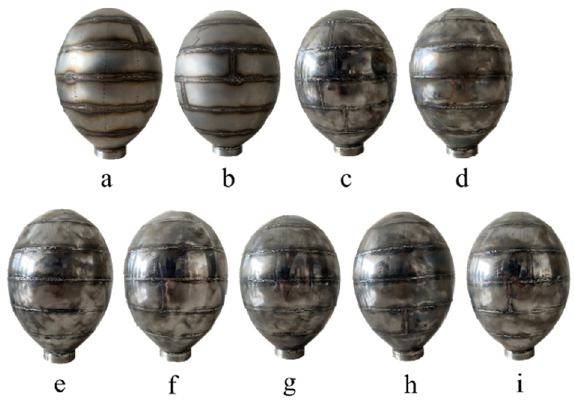
Figure 13. Photo of egg-shaped pressure hulls.